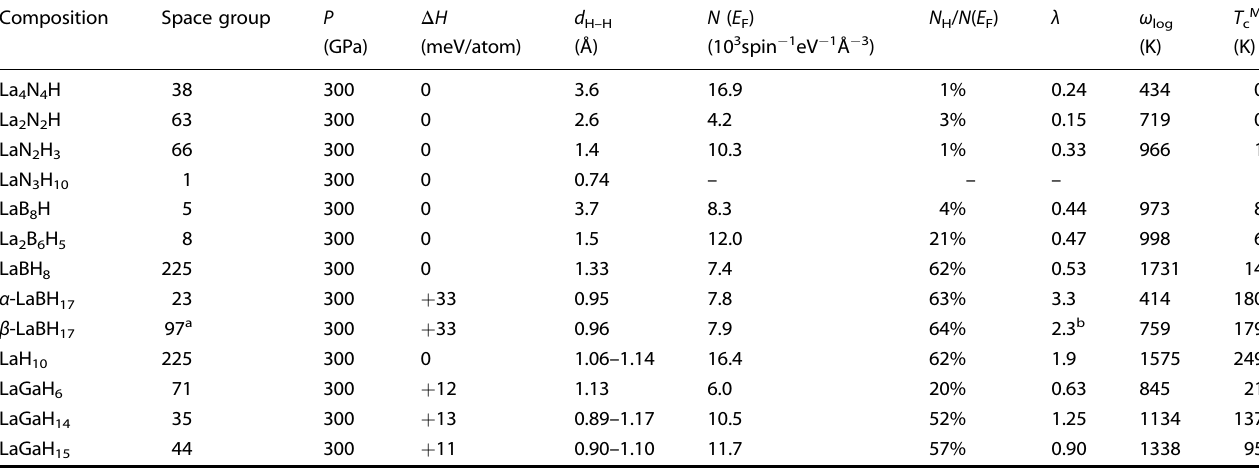
Table 1. Electronic and superconducting properties of selected ternary phases of La – N – H and La – B – H, plus high-symmetry metastable La – Ga – H